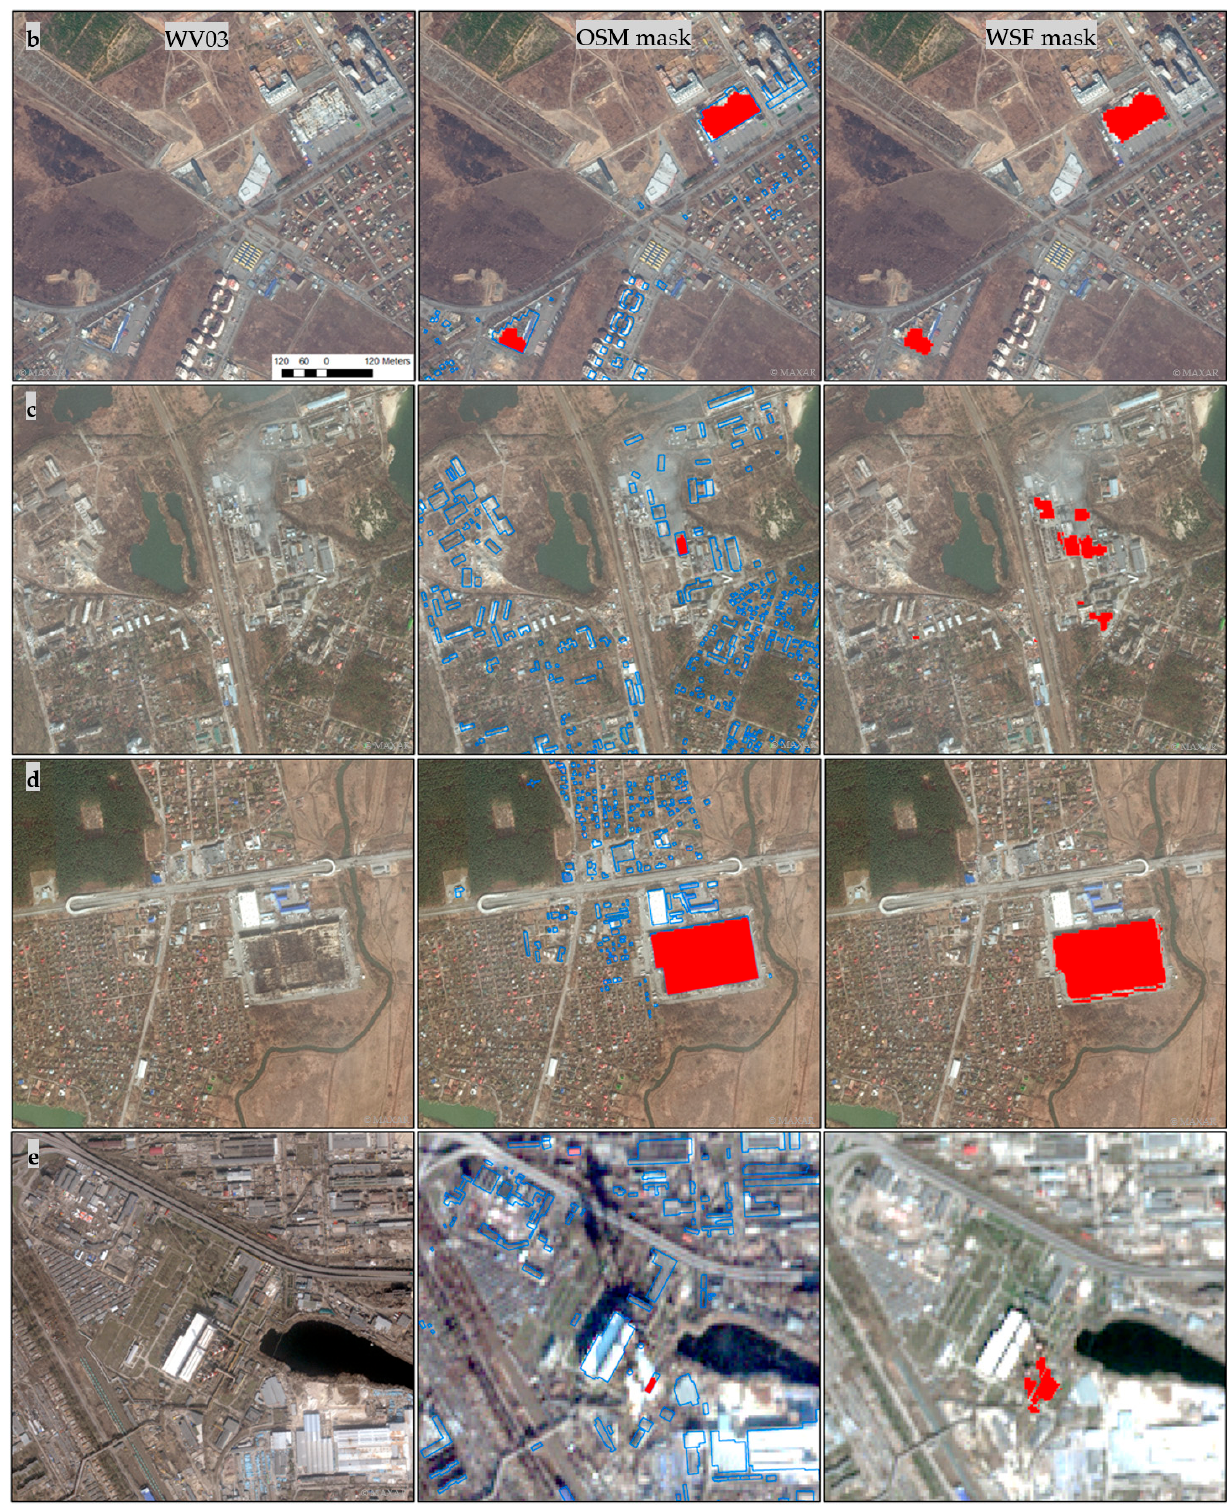
Figure 8. The result of Sentinel-2 texture-based analysis for study region ( a ). ( b – e ) are comparison of Sentinel-2 damaged building results using two different masks (OSM&WSF). The locations ( b – e ) are referenced in ( a ) and were selected as representative areas for comparison with the high-resolution WorldView image. The columns from left to right indicate the WorldView image (25 March 2022 & 31 March 2022), OSM and WSF mask results of the damaged buildings. The scale shown in ( b ) is the same for ( c – e